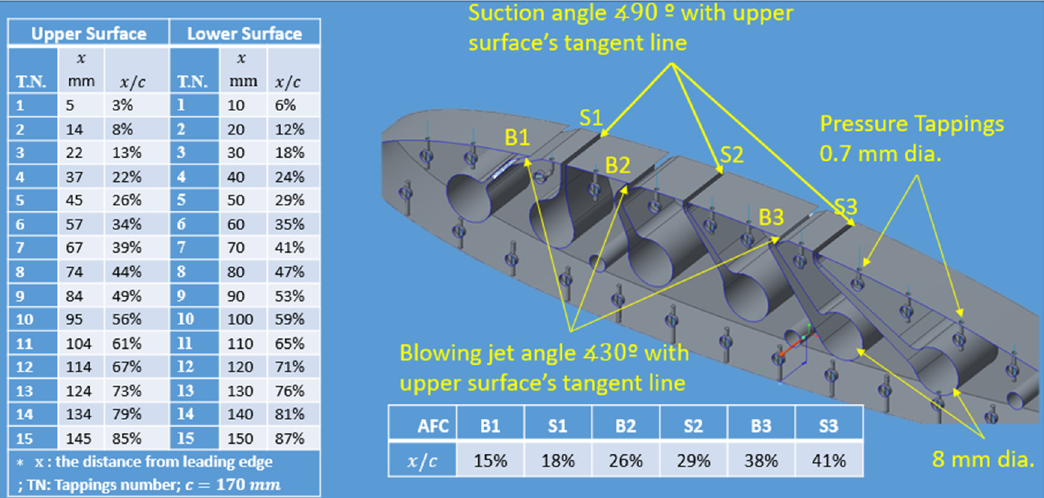
Fig. 4. The NREL ’ s S822 Aerofoil prototype model: blowing (B) and suction (S) slots locations along the aerofoil pro fi le chord and the pressure tapping distributed around the section.